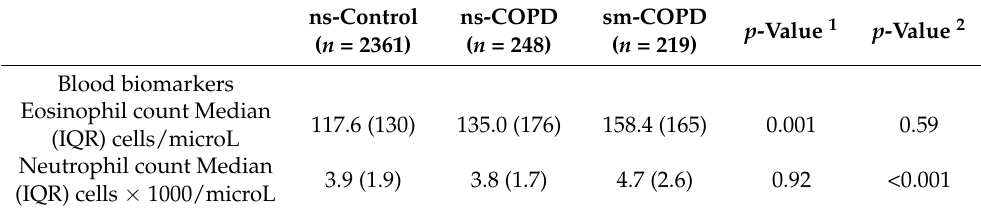
Table 4. Blood biomarkers in ns-Controls, ns-COPD, and sm-COPD